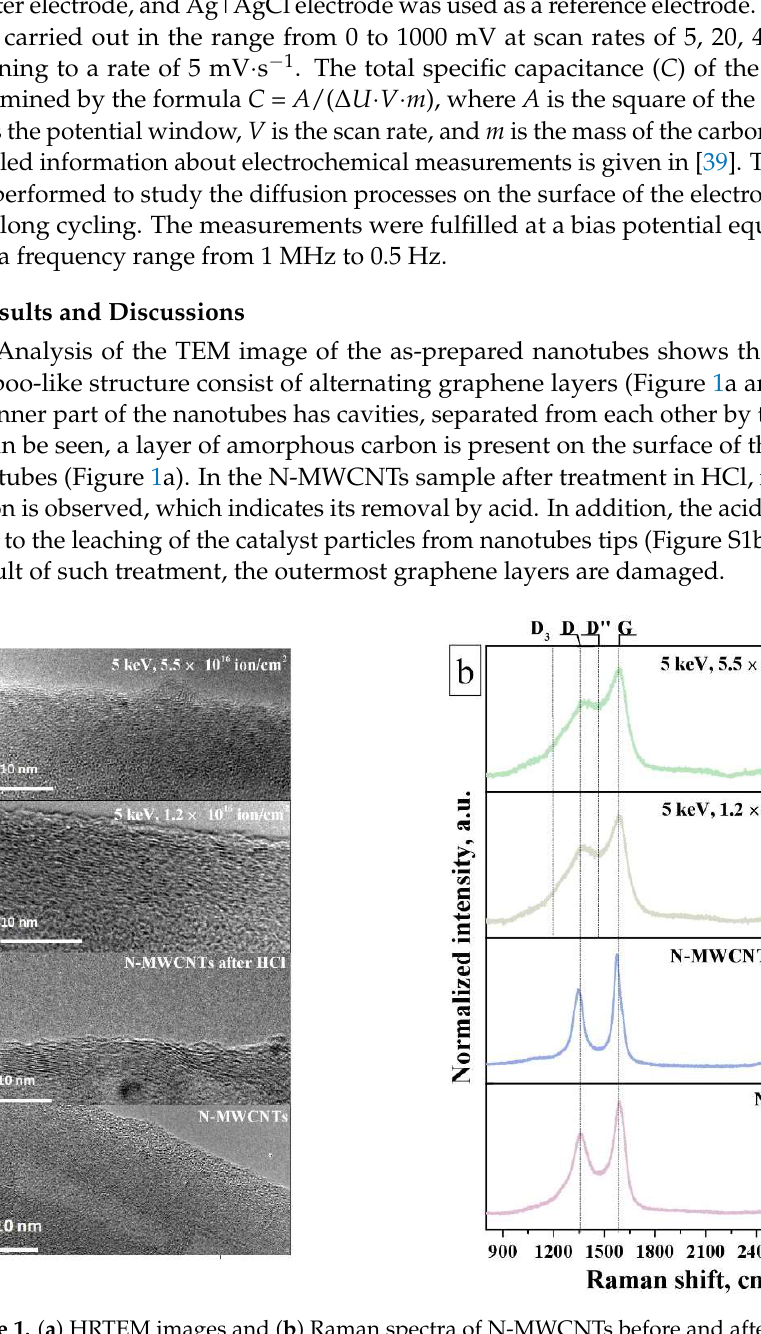
Figure 1. ( a ) HRTEM images and ( b ) Raman spectra of N-MWCNTs before and after treatments.